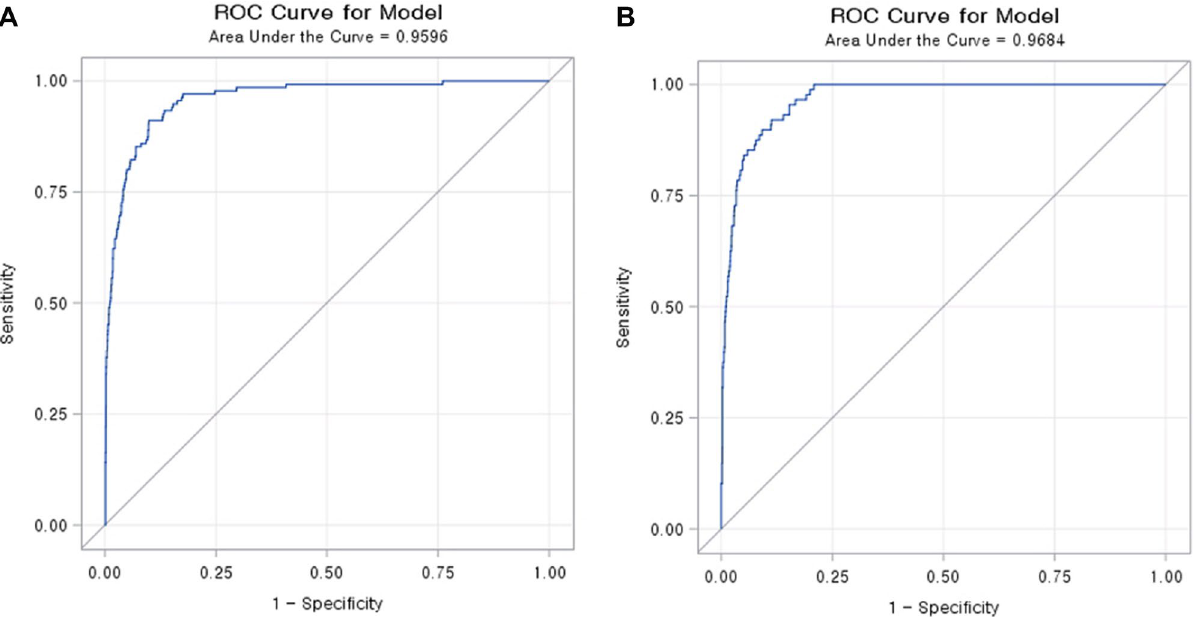
Figure 4. Performance of the mortality prediction models on development set ( A ) and validation set ( B